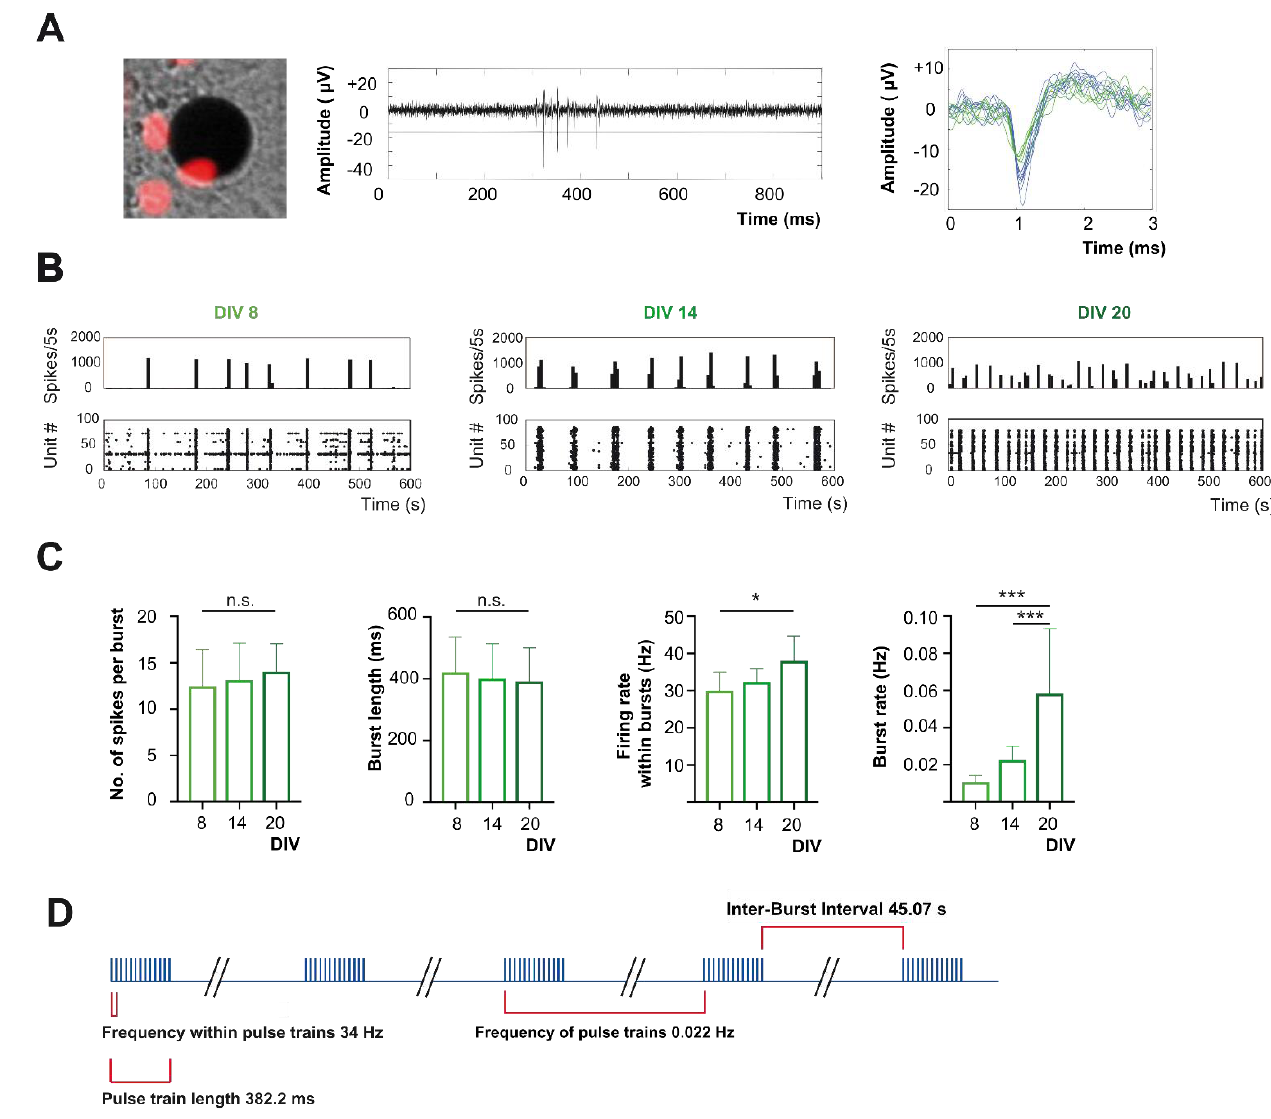
Figure 2. Design of stimulation protocol based on characteristics of spontaneous network activity during late development. ( A ) H2B-mCherry positive neurons on one of the 120 MEA-electrodes with the corresponding raw trace of electrical activity recorded. In this example, the electrode picks up action potentials with two distinct shapes above the detection threshold. Spike sorting algorithms grouped action potentials into two clusters and thus assigned them to two different putative neurons. ( B ) Example time histograms and raster plots of spontaneous activity at DIV8, DIV14, and DIV20. Time histograms spike rates were calculated in 5 s time bins. Note that during late development, neuronal firing patterns of cortical cultures are dominated by coherent bursting activity. ( C ) Quantification of properties of neuronal activity patterns. The number of spikes per burst and the burst length appeared to be stable between DIV8 and DIV20 ( n = 20/5/5; p > 0.05). The firing rate in bursts increases significantly ( p = 0.012) between DIV8 and DIV20. The firing rate of bursts increases significantly between DIV8 and DIV20 ( p < 0.0001) and between DIV14 and DIV20 ( p < 0.001). ( D ) Design of burst stimulation protocol mimicking spontaneous physiological activity. We based the burst stimulation protocol on the averages of the bursting parameters analyzed at DIV14. Data points indicate mean ± SEM and *, *** indicate p -values <0.05, and <0.001, respectively. The burst rate (DIV8 0.01 ± 0.001 Hz, DIV14 0.02 ± 0.003 Hz, DIV20 0.06 ± 0.016 Hz, n = 20, 5 and 5 cultures; one-way ANOVA p < 0.05) increased significantly between DIV8 and DIV20 ( p <0.0001 posthoc test) and between DIV14 and DIV20 ( p = 0.001 posthoc test). The number of spikes per burst (DIV8 12.48 ± 0.89, DIV14 13.13 ± 1.78 and DIV20 14.05 ± 1.34) and the burst length (DIV8 421.3 ± 25.65, DIV14 401.3 ± 50.11 and